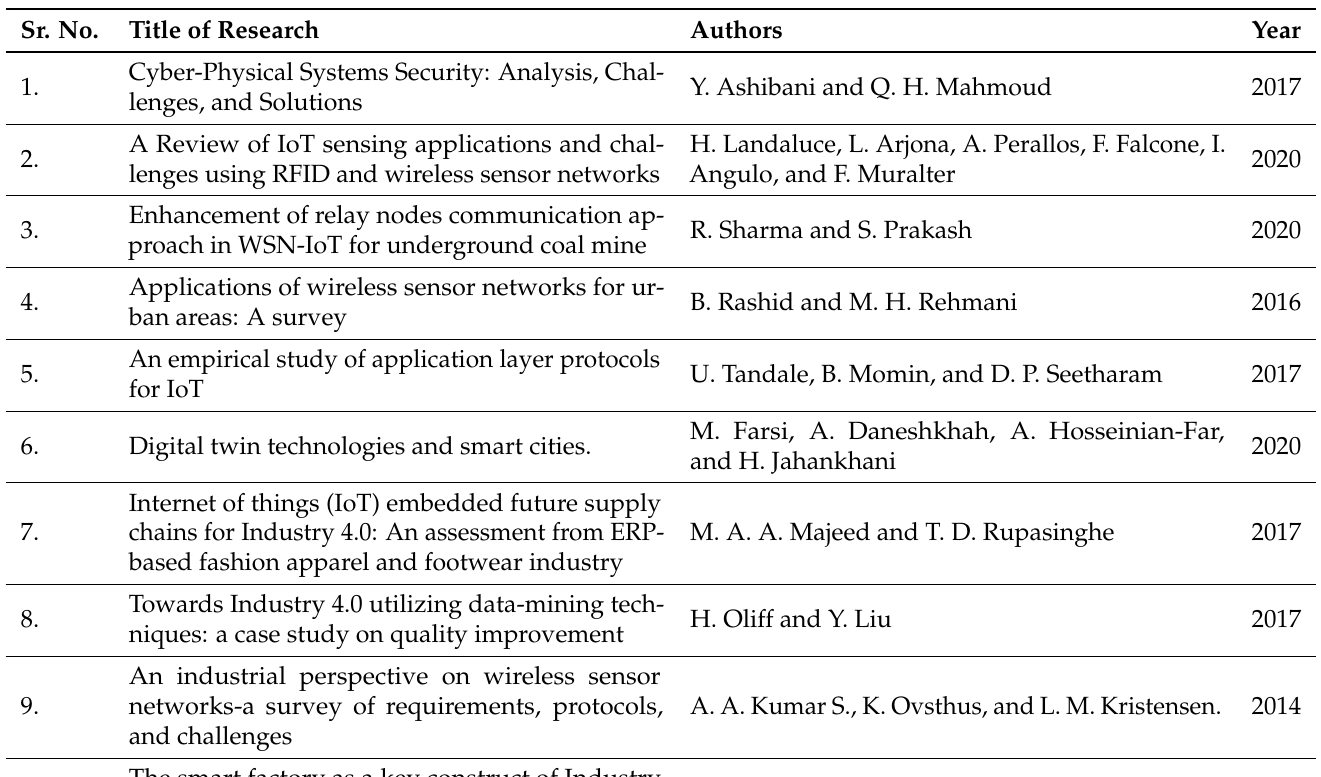
Table 7. Selected studies used for SLR